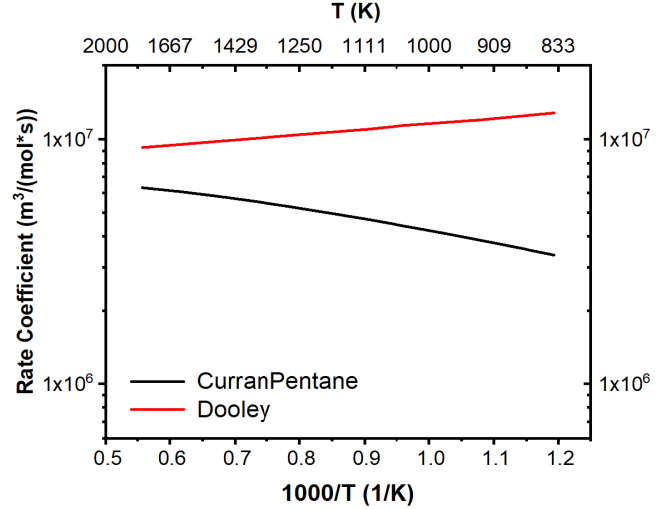
Figure 7. Rate coefficient of C 3 H 5 -A + HO 2 <=> C 3 H 5 O + OH reaction based on the CurranPentane and Dooley mechanisms at 10 bar.